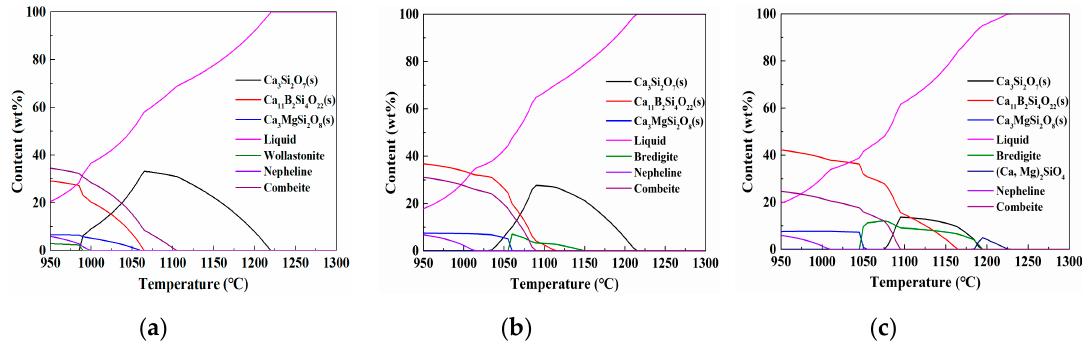
Figure 8. Crystallization phase of fluorine-free mold fluxes during cooling. ( a ) R = 1.15; ( b ) R = 1.25; ( c ) R = 1.35.